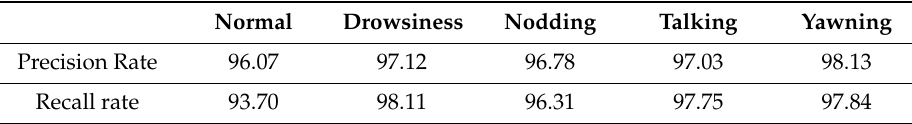
Table 4. Precision rate and recall rate (%) for di ff erent